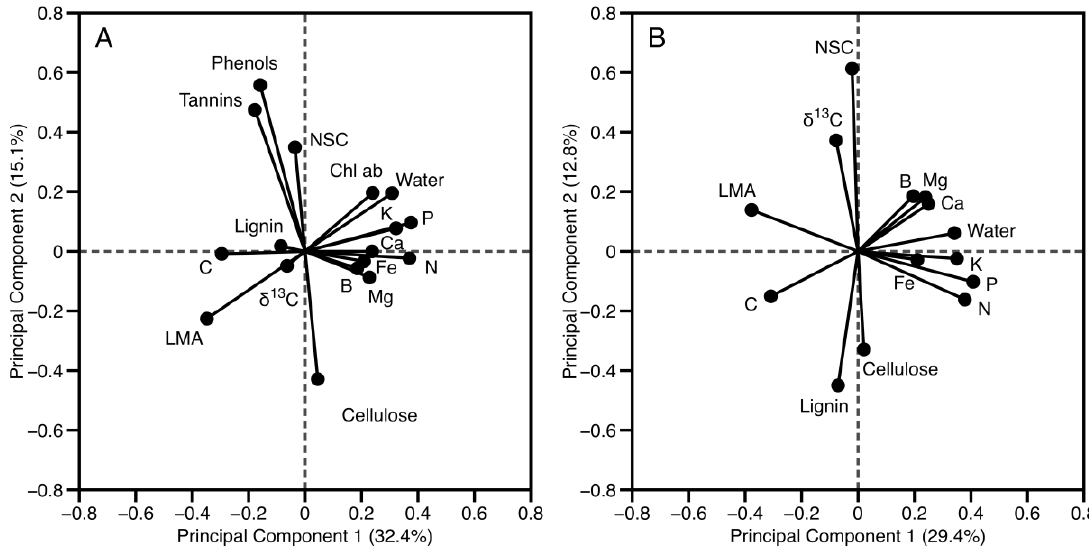
Figure 4. Principal components analysis of ( A ) 17 foliar traits measured in the lowlands locations ( n =